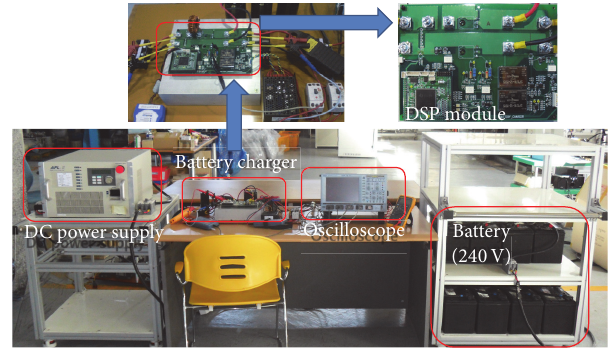
Figure 5: System hardware front-view picture.